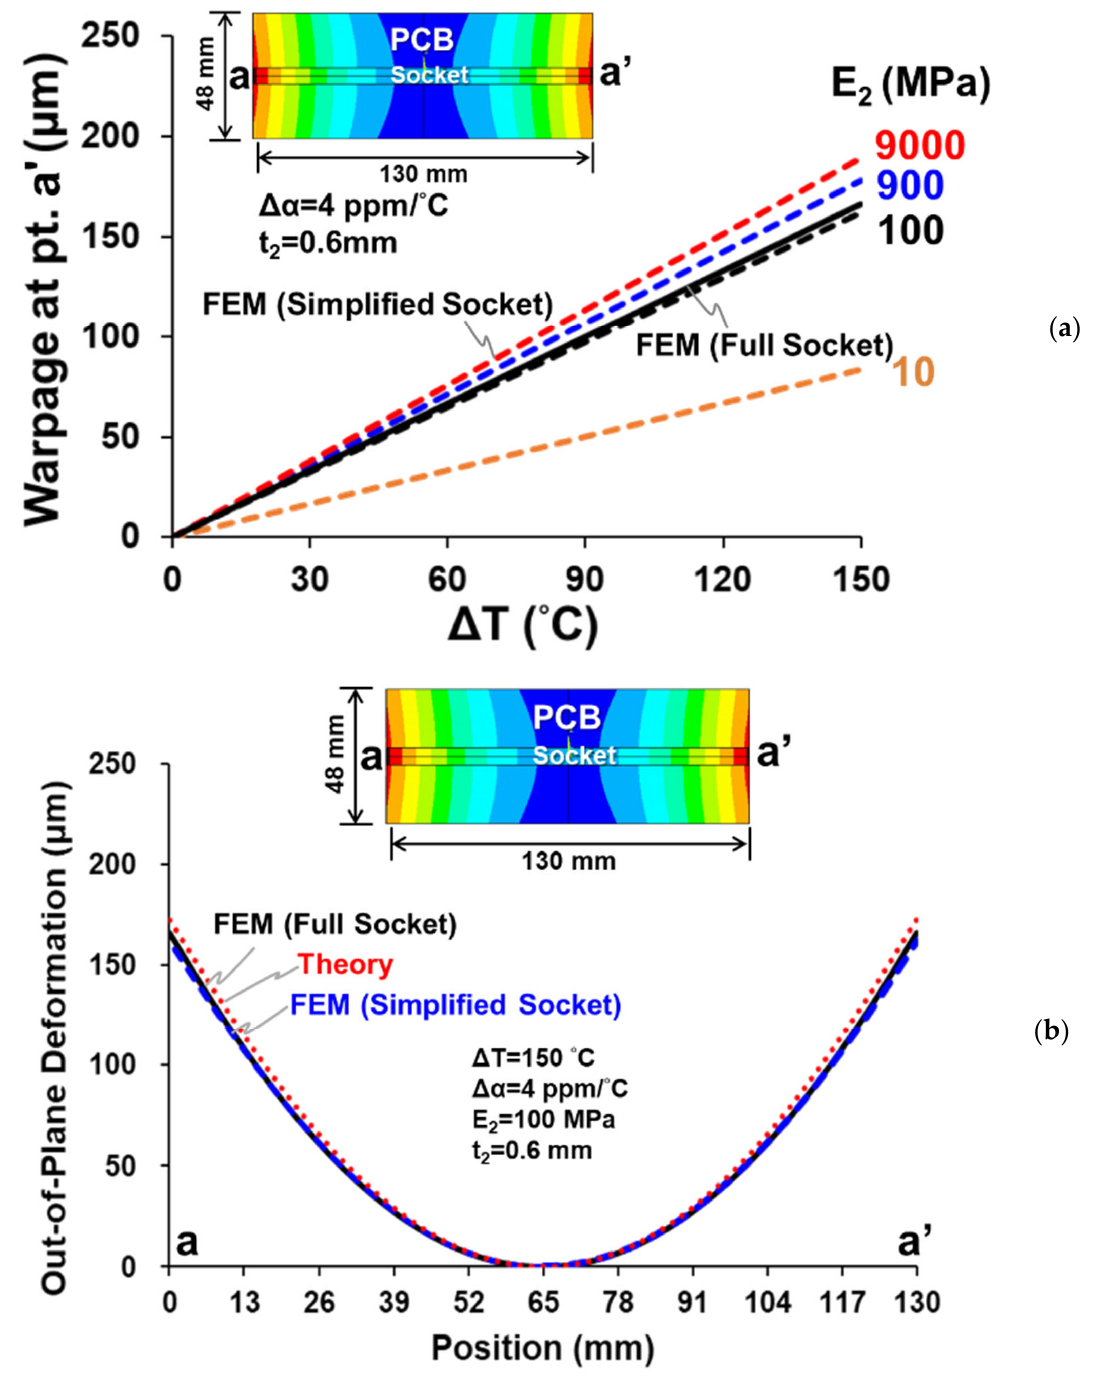
Figure 12. ( a ) Thermally induced warpage (plus an inset of full-field deformation contours) of a one-socket-PCB assembly with various effective moduli of the joint under different thermal loadings ( ∆ T) from FEM with full and simplified socket models, and ( b ) the out-of-plane deformations (along the line a-a’) of the one-socket-PCB assembly under thermal loading ∆ T = 150 ◦ C, from the theory and FEM simulations with full and simplified socket models.